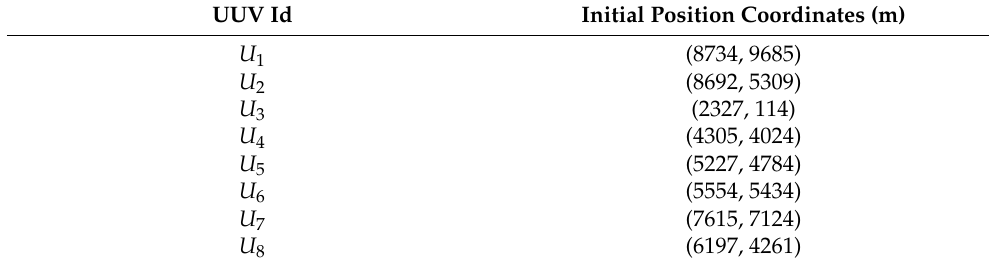
Table 5. UUV initial position.